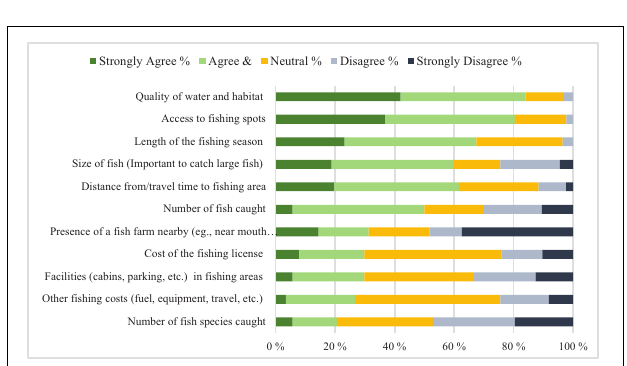
FIGURE 4 | Factors that affect the enjoyment of anglers’ fishing